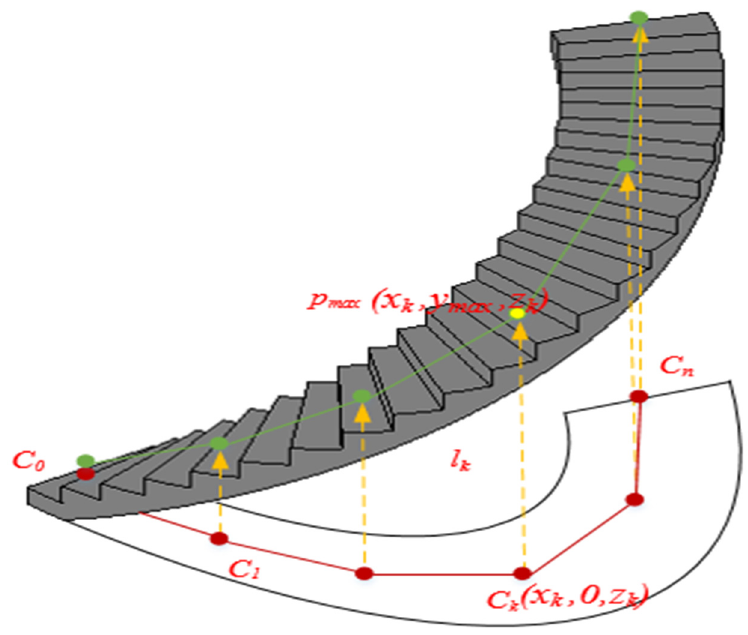
Figure 12. Illustration of the algorithm logic for Path-BIM intersection.